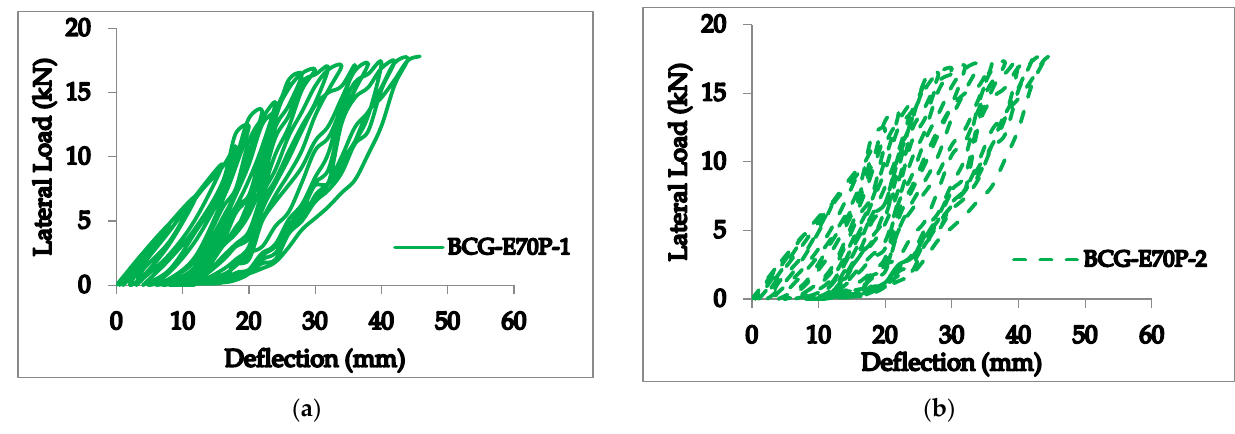
Figure 11. The hysteretic curve of the GFRP-ECC70P beam-column. ( a ) Specimen 1; ( b ) specimen 2.